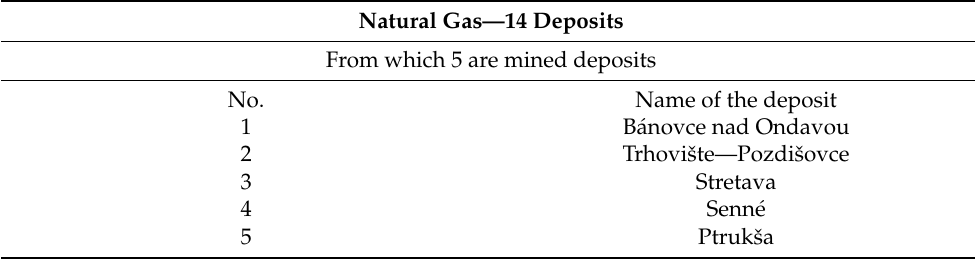
Table 2. List of currently valid extracted natural gas deposits, (source: elaborated by